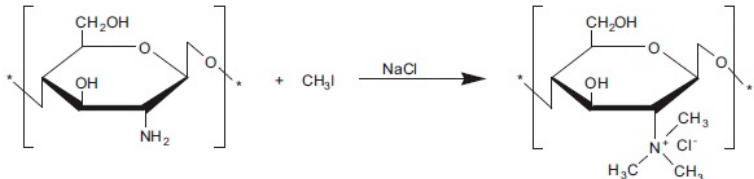
Figure 12. Synthesis of quaternized CS [176]. Copyright 2013, reproduced with permission from Elsevier